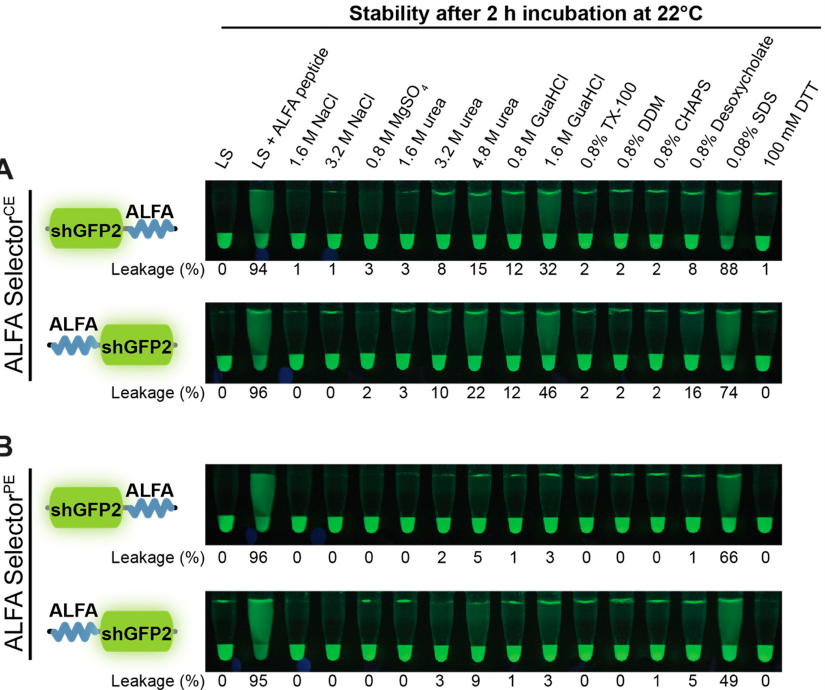
Figure 4. Buffer compatibility. ALFA Selector CE ( A ) and ALFA Selector PE ( B ) were saturated with shGFP2-ALFA (upper panels) or ALFA-shGFP2 (lower panels), washed extensively with PBS and incubated in a 10-fold volume of the indicated substances for 2 h at 22 °C. The leakage of target protein from the Selector resin was analyzed by quantifying the fluorescent material released into the supernatant before (shown here) and after post-elution with ALFA peptide (control shown in Figure S3). The degree of leakage/dissociation of target protein from the beads is given as % of